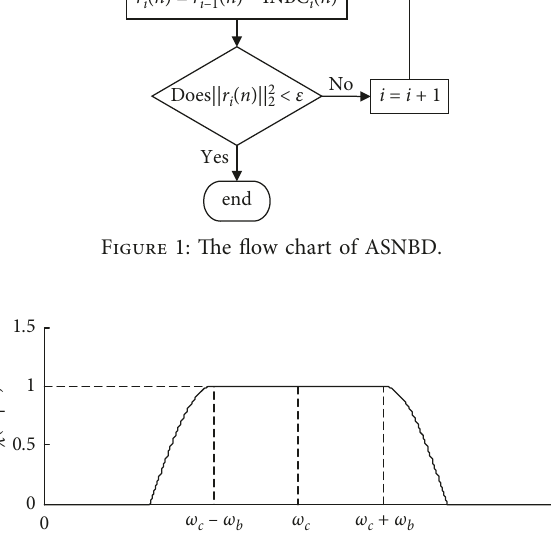
Figure 2: The filter given in equation (6).